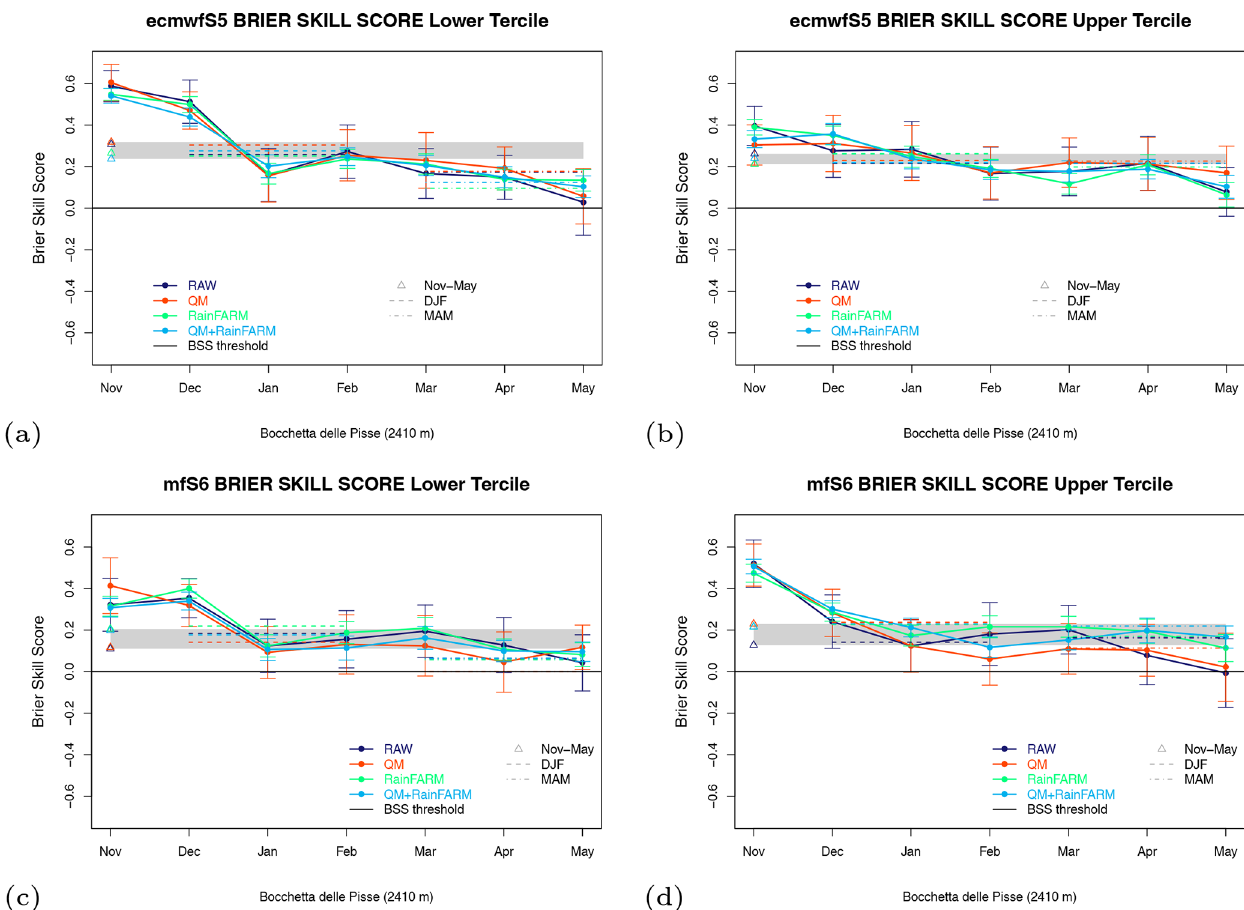
Figure 7. Brier skill score for seasonal forecasts of monthly and seasonally averaged snow depth in the (a, c) lower and (b, d) upper terciles for (a, b) ECMWFS5 and (c, d) MFS6 forcing, starting date 1 November, lead times from 1 to 7 months for the site of Bocchetta delle Pisse. Coloured dots represent the BSS for each month and each experiment; dashed (dotted-dashed) horizontal lines represent DJF (MAM) BSS values; and the grey-filled rectangle and the four coloured triangles all refer to the seasonal (November–May) values, indicating the BSS spread (min–max) and the single BSS values for the four experiments, respectively.